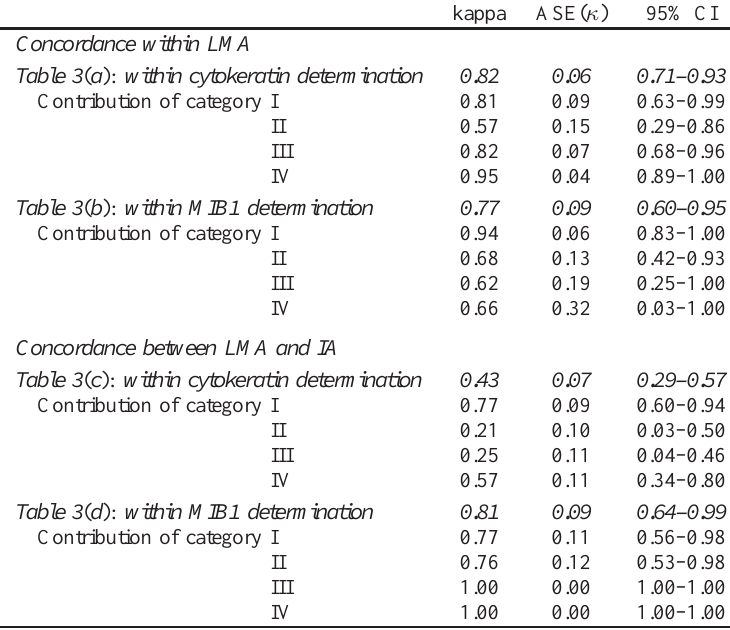
Table 5 Contribution of each category ( κ cs ) a to the overall unweighted agreement ( κ u ) b